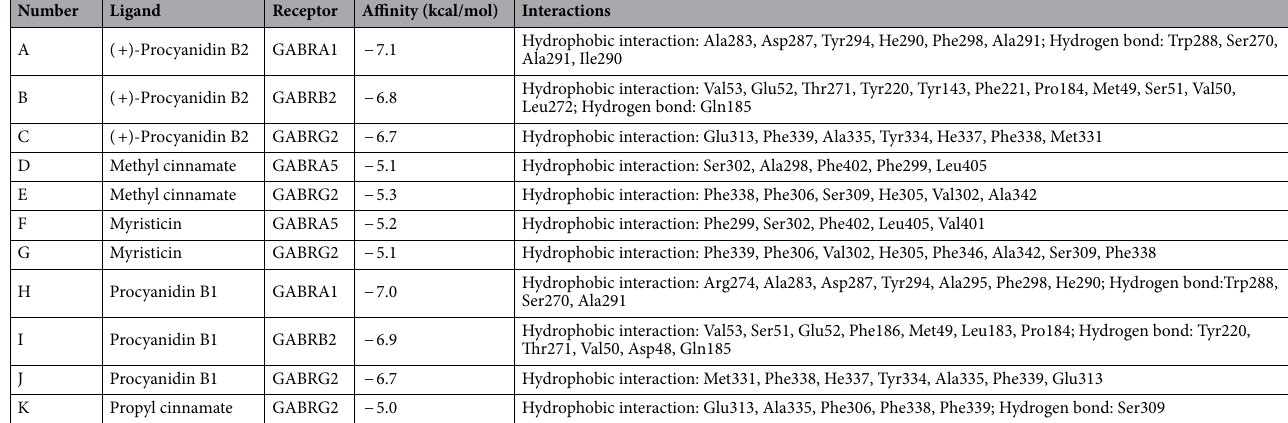
Table 2. Interaction between the compounds and the protein